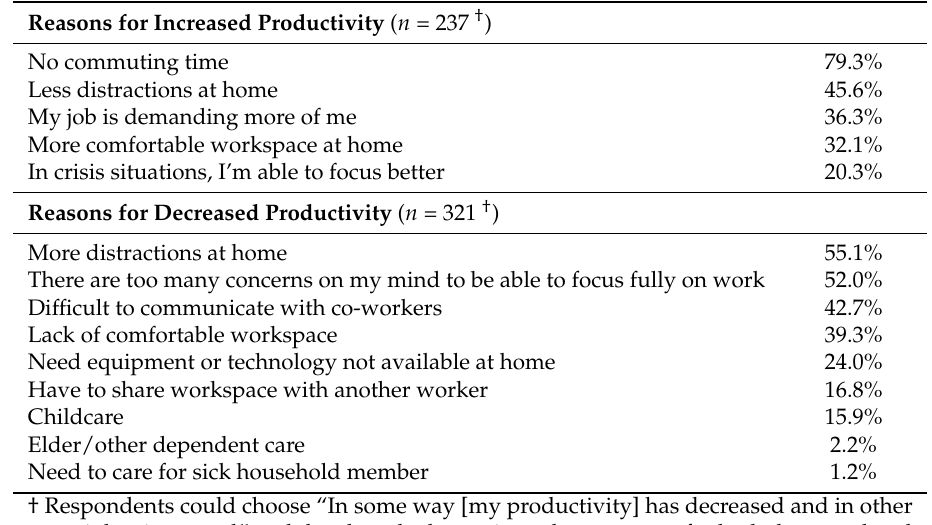
Table 2. Reasons for a change in productivity among those who started working from